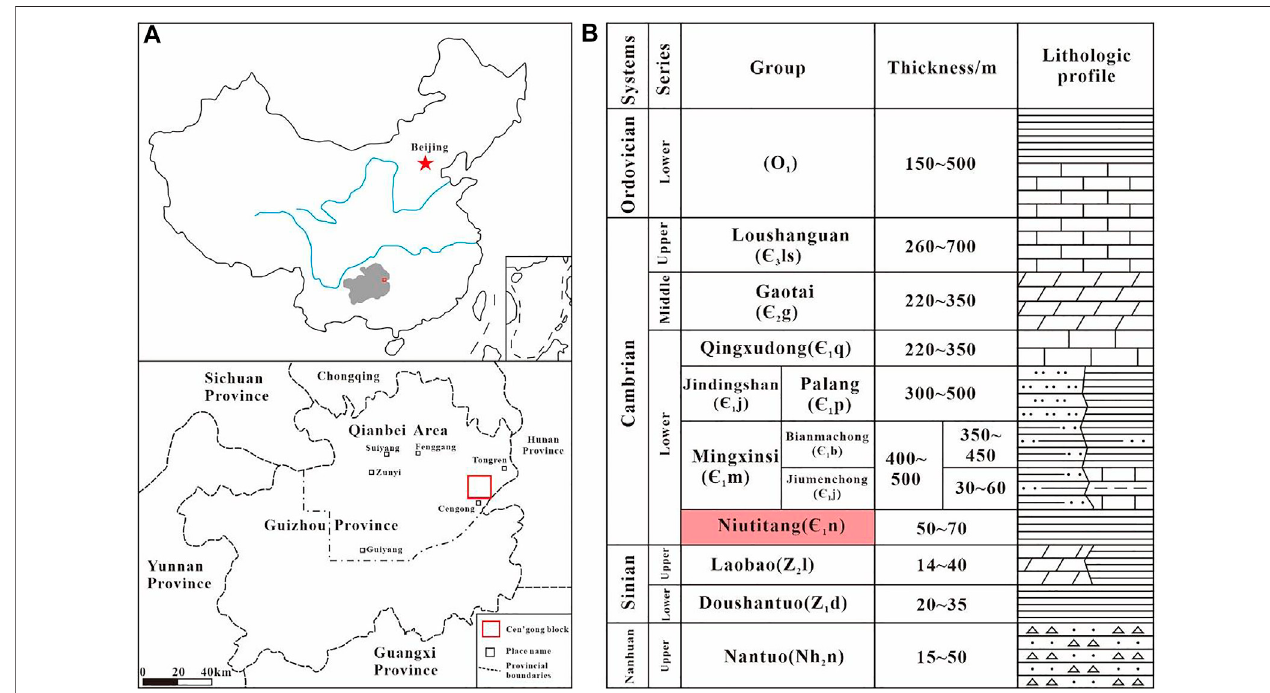
FIGURE 1 | (A) Location of Cen ’ gong block; (B) stratigraphic column of the study area.